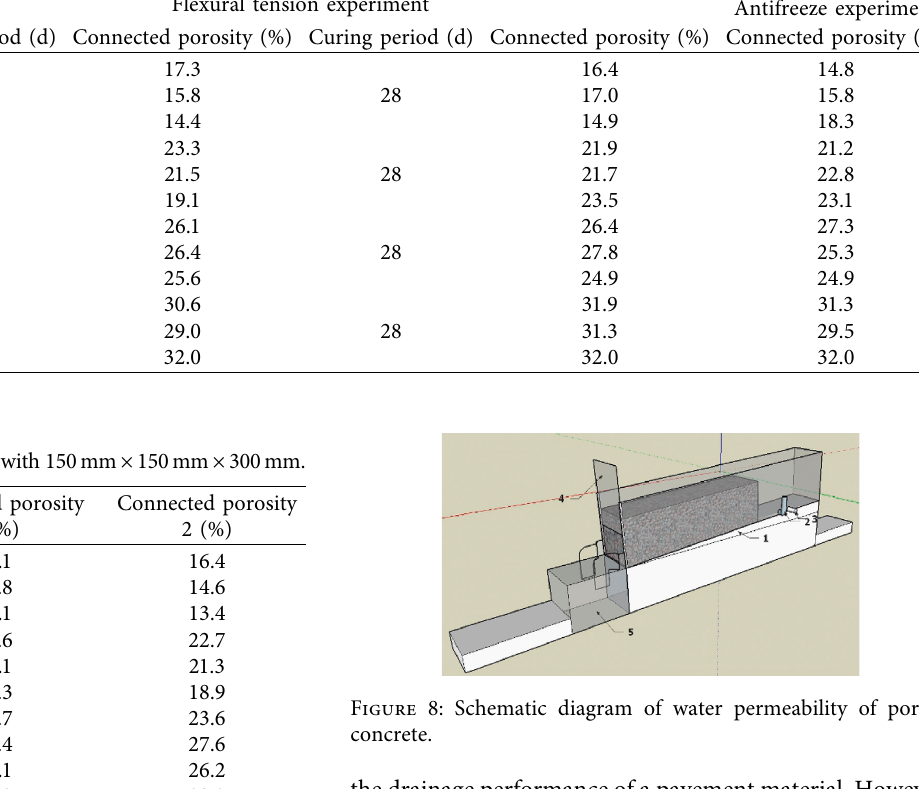
Table 7: Test results of specimen with 150mm × 150 mm × 400mm. Goal porosity (%)